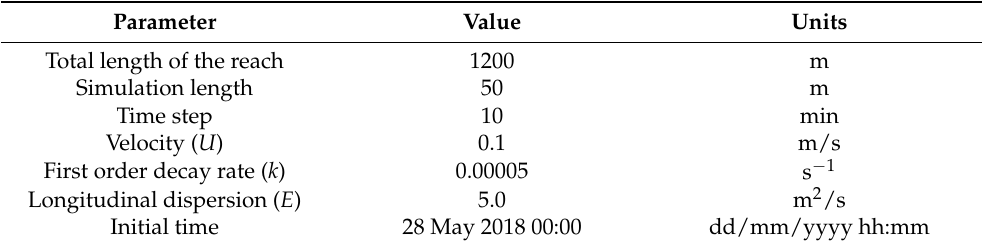
Table 1. Parameters values used in the example problem.